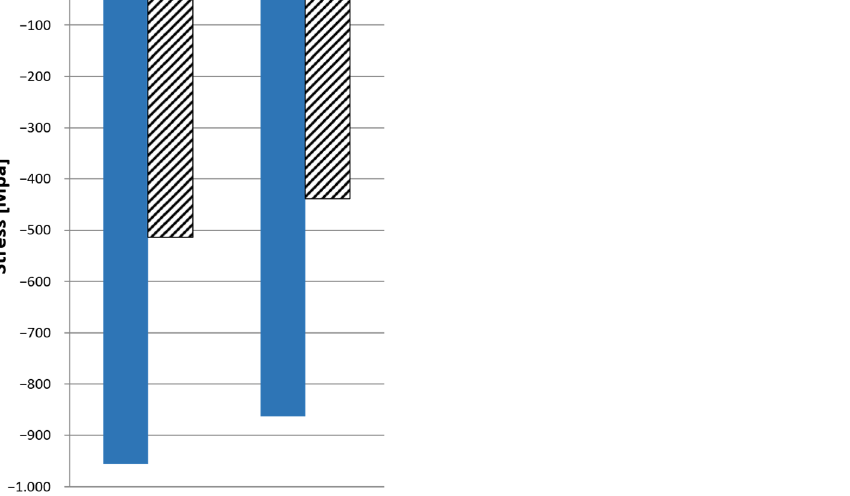
Figure 19. Comparison of residual stresses on external surface for nitride (blue bars) and not nitride (black hatched bars) specimen obtained by XRD.